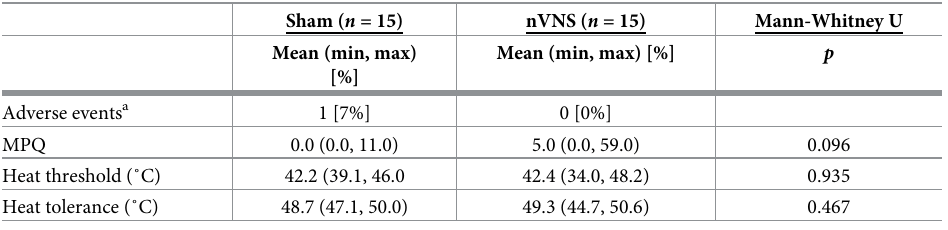
Table 2. Baseline pain